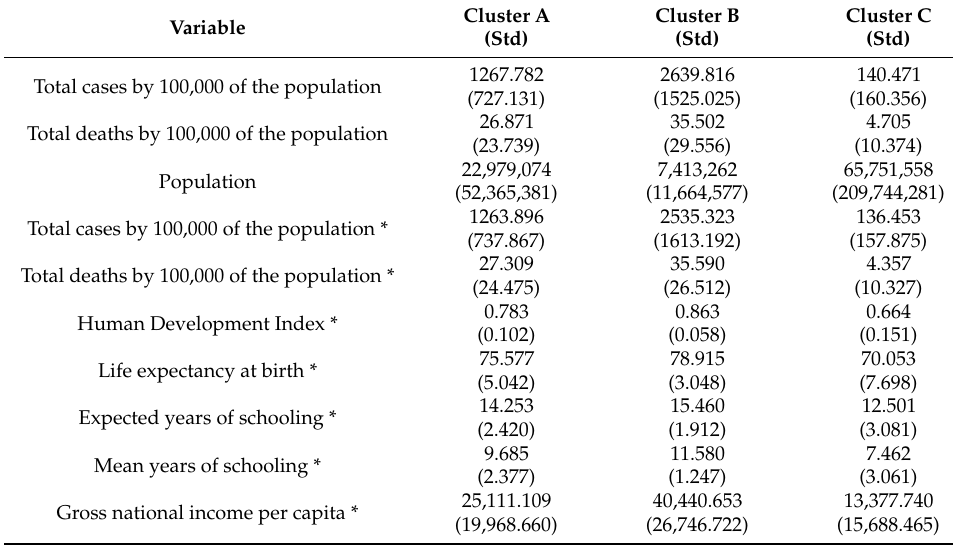
Table 5. Averages and standard deviations (std) of variables per cluster of cases at Day 250 (* excluding the 24 countries/territories that are not present in the UNDP dataset).